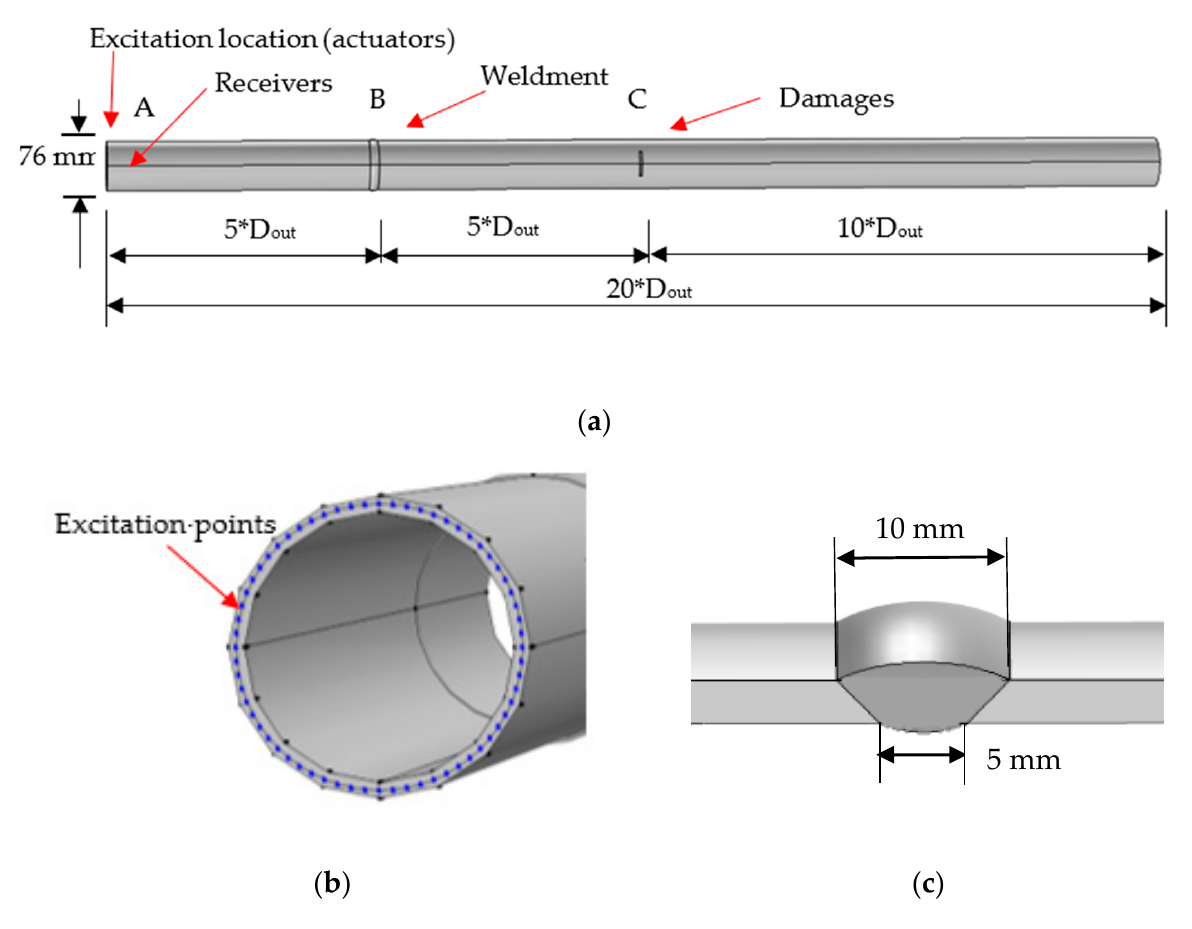
Figure 12. FE modeling of a pipe. ( a ) Steel pipe with a welded joint and notch-shaped damage. ( b ) Excitation nodes. ( c ) V-shaped weldment.